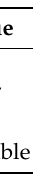
Table 1. Basic parameters of ADNB [32].